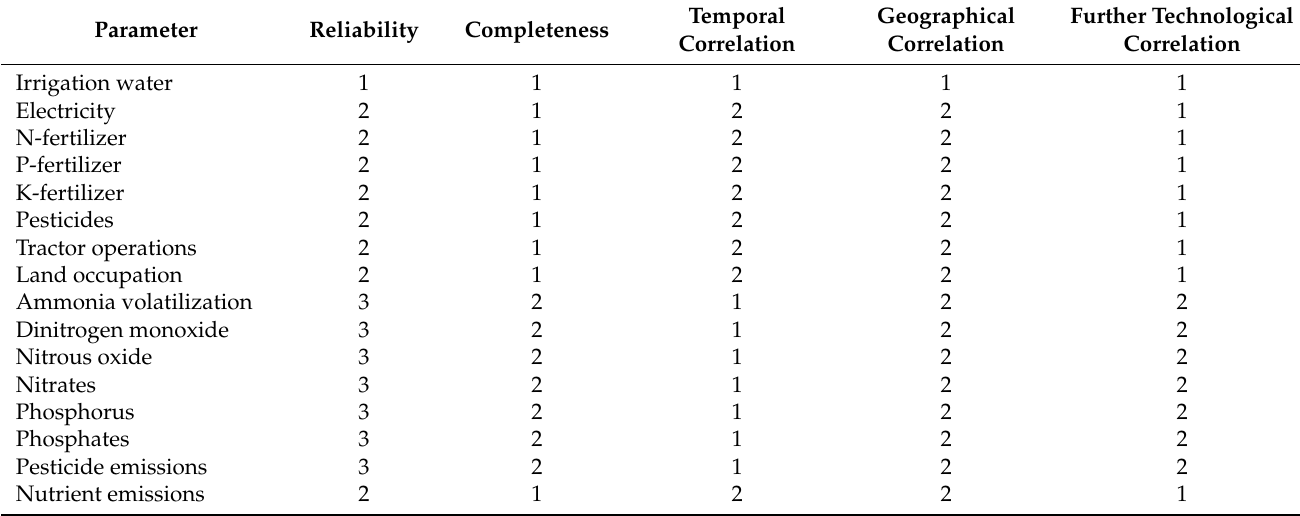
Table A1. Data quality indicators (reliability, completeness, temporal correlation, geographical correlation, further techno- logical correlation) used for uncertainty